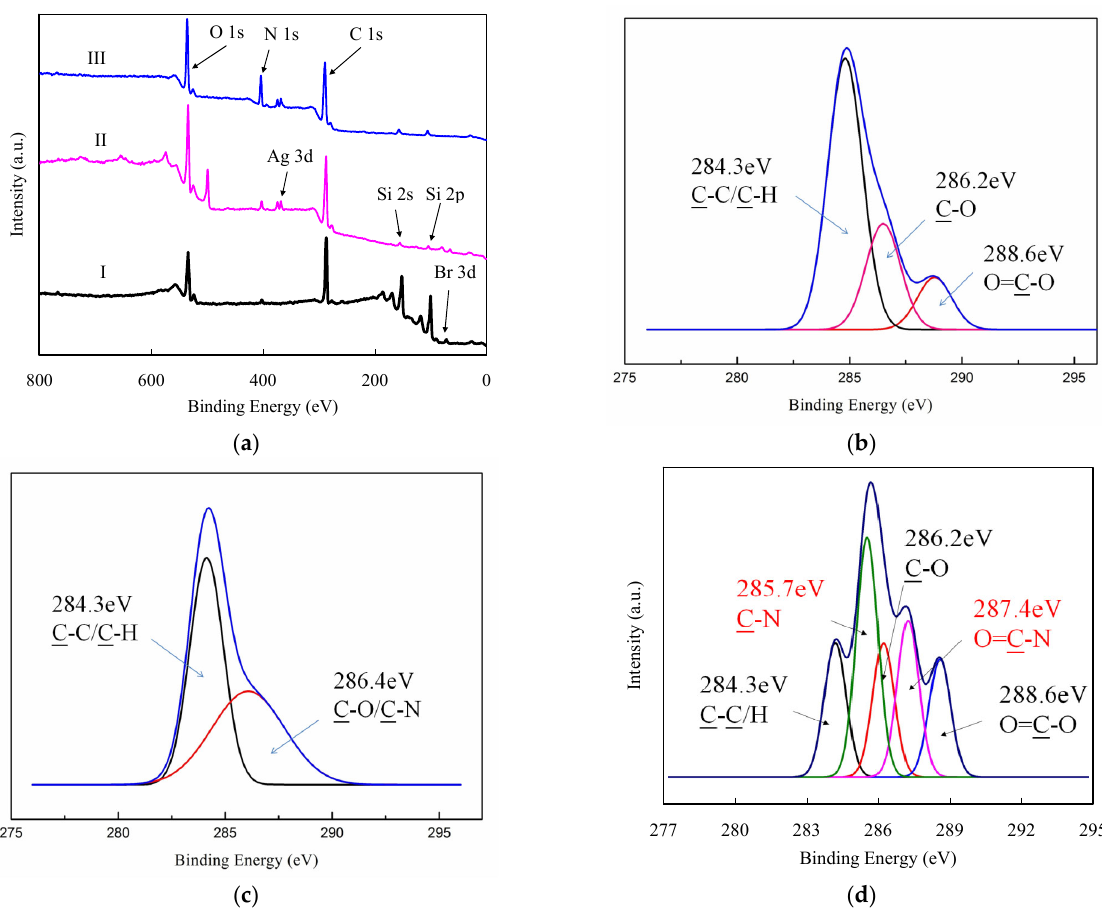
Figure 1. ( a ) XPS survey profiles of PMAA (I), AgCs–PMAA (II), and abY-grafted AgCs–PMAA (III). ( b – d ) Deconvoluted C 1s high-resolution spectra of ( b ) PMAA, ( c ) AgCs–PMAA, and ( d ) abY-grafted AgCs–PMAA. Table 1. Surface compositions of PMAA, AgCs-PMAA, and abY-grafted AgCs-PMAA obtained from the areal ratios of peaks in core-level X-ray photoelectron